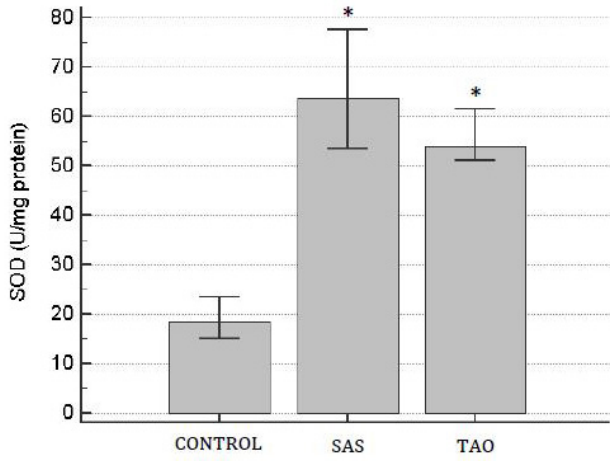
(TAO). Values are expressed in mean and the brackets represent interval of confidence of 95%. ANOVA followed test t. *P<0.05 when compared to SAS group.